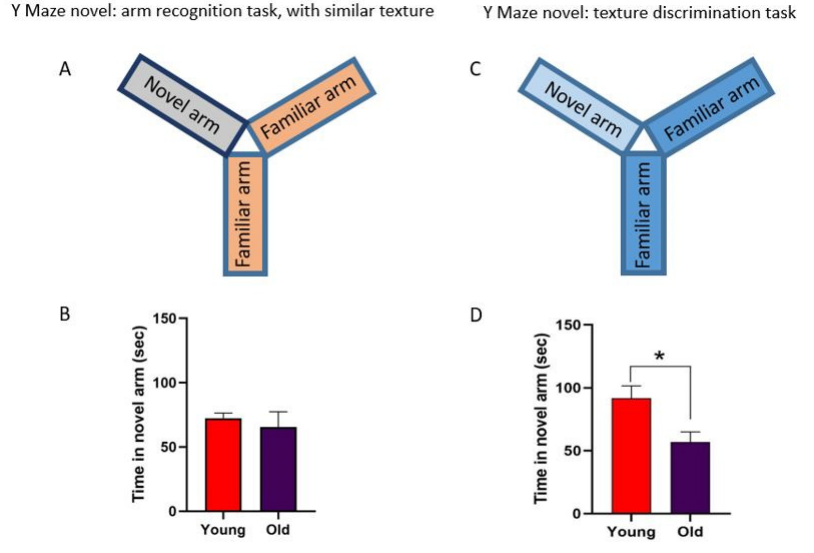
Figure 5. Results of Y-maze whisker-dependent texture discrimination. ( A , B ) Diagram and plot showing the time spent in the novel arm without any difference in the texture; young and old mice spend the same time in the novel arm (n = 7 in each group; Mann–Whitney unpaired test p = 0.8939). ( C , D ) The plot shows the time in seconds that the animal spent on the new arm with the new texture. Young mice spent more time exploring the new arm than old mice (n = 7 in each group; Mann–Whitney unpaired test, two-tailed test *, p = 0.012).